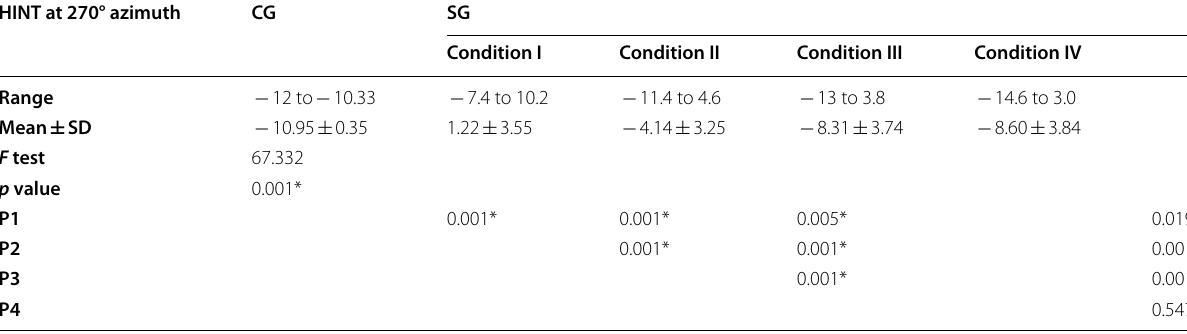
Table 5 Comparison among CG and SG conditions I, II, III, and IV using noise at 270°